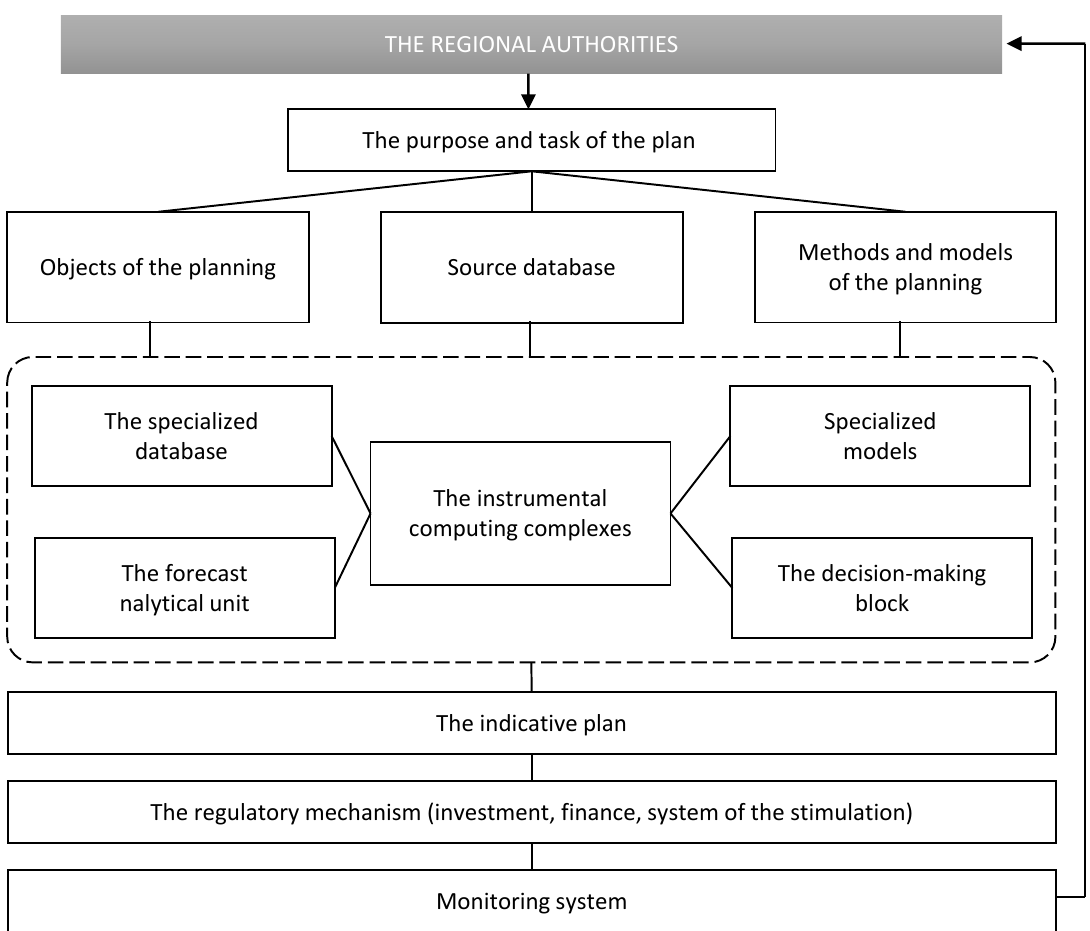
Figure 2. Technology and methods of developing an indicative plan for the region’s